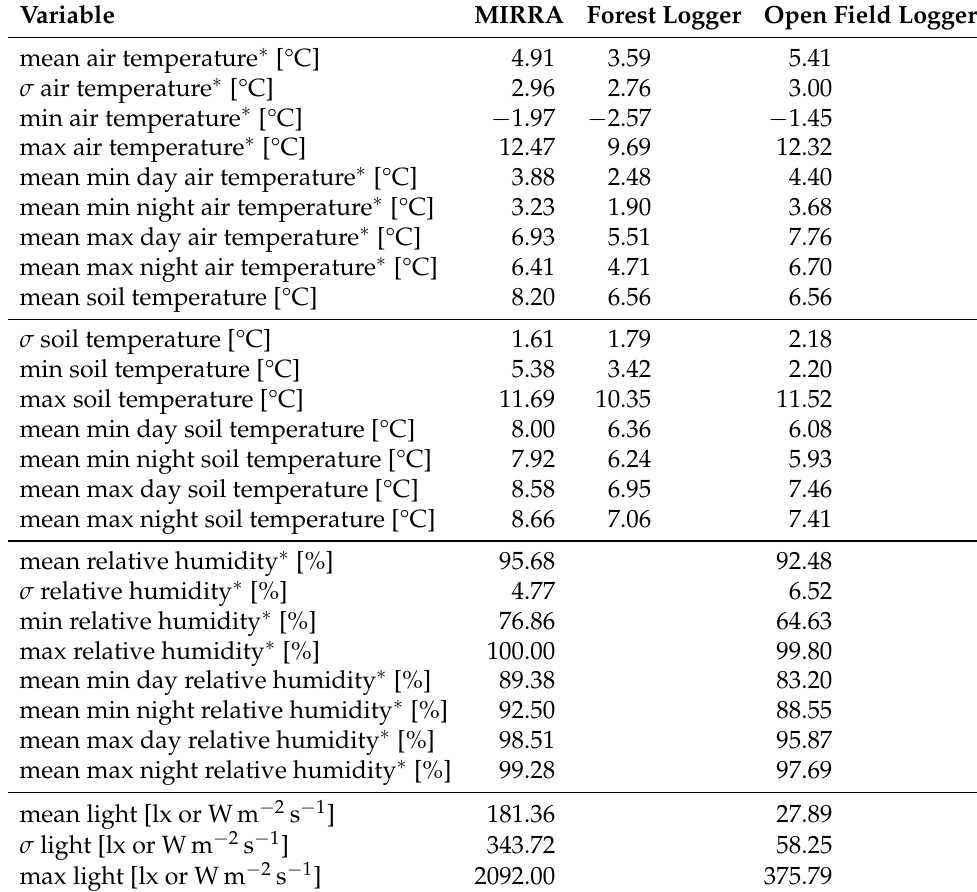
Table 4. Overview of statistical properties of the three data sets. σ is the standard deviation. Light is reported in lx and Wm − 2 s − 1 for the MIRRA and open field loggers, respectively. ( ∗ ) these variables are computed only between 26 November and 15 December because no data is available for the open field logger for earlier time points.